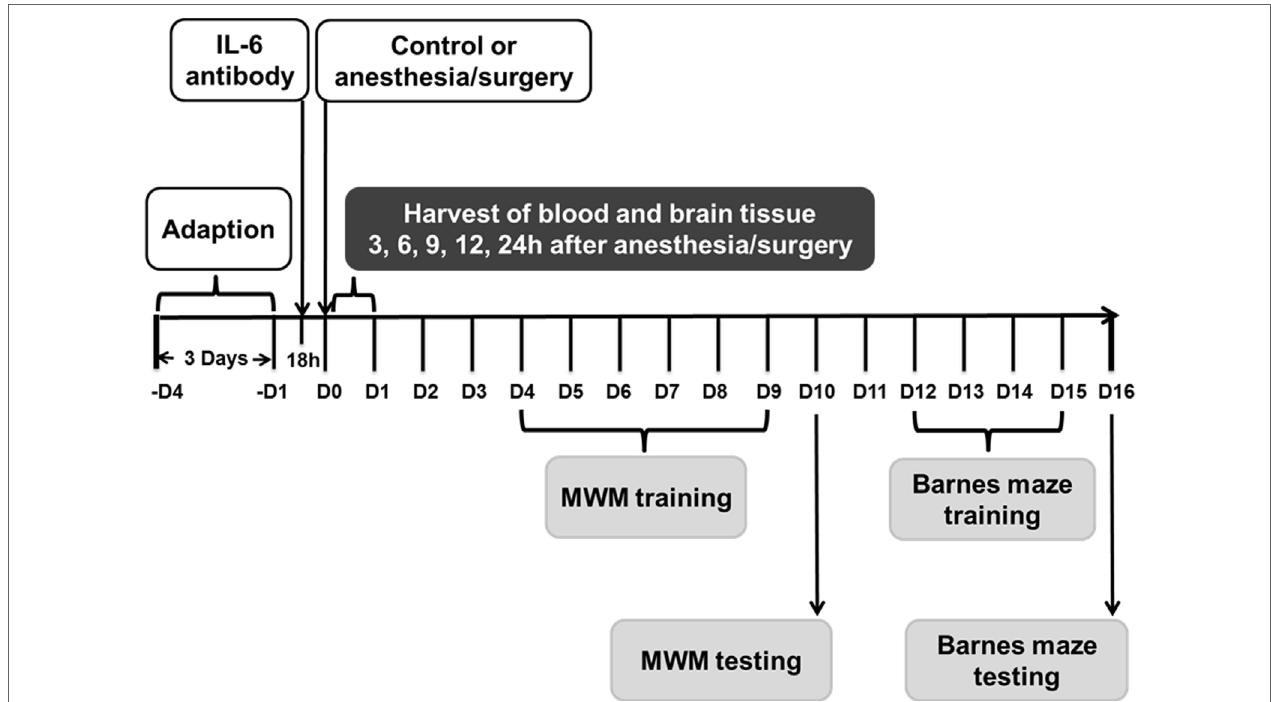
FigUre 1 | Experimental design. Nine- and eighteen-month-old mice received the anesthesia/surgery or control condition. The blood and brain tissues were harvested at various time points after the anesthesia/surgery. Different group of mice were used for MWM and Barnes maze studies. Interleukin (IL)-6 antibody was used in the intervention studies. MWM, Morris water